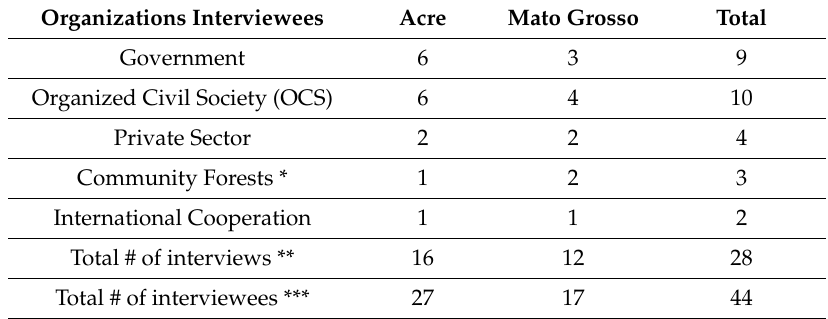
Table 2. Social segments interviewed in this survey and the number of interviews and interviewees. Organizations Interviewees